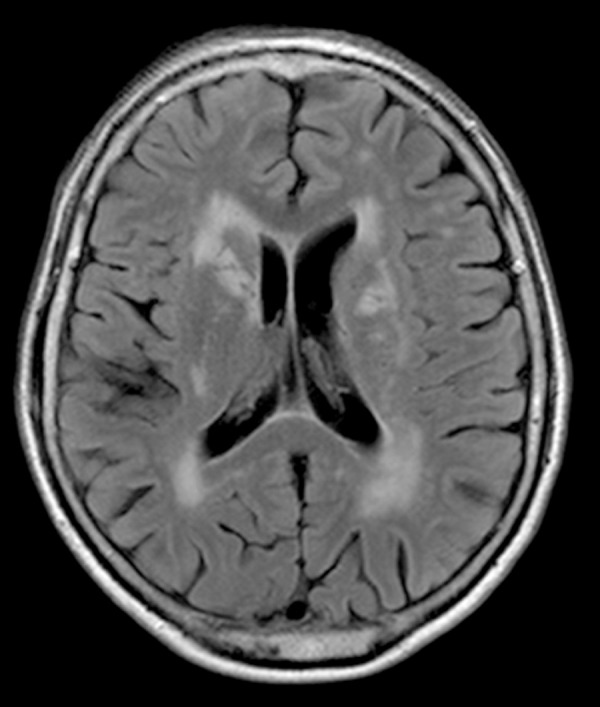
Flair MRI revealing moderate-severe lesions in white matter.